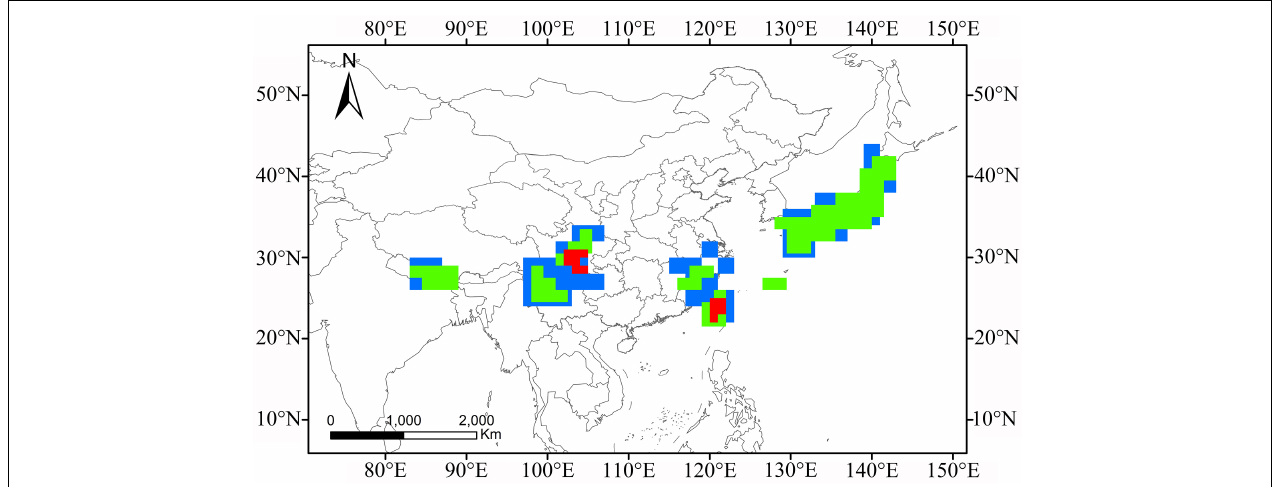
FIGURE 6 | Overlap of the consensus AOEs detected for Lycocerus by EA employing 1 ◦ (red shadows), 1.5 ◦ (green shadows), and 2 ◦ (blue shadows) grid size.